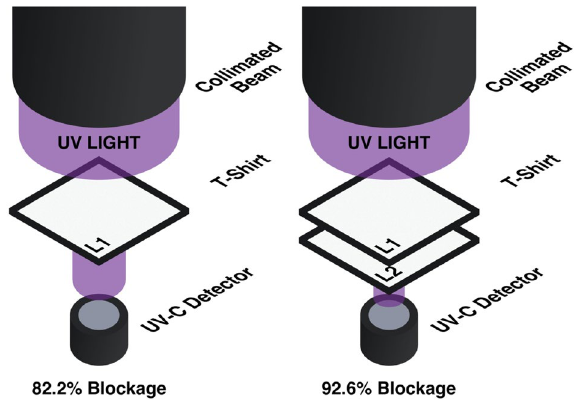
Figure 5. UV-C light penetration through different T-shirt cotton layers. L1 = one layer; L2 = two combined layers (n =